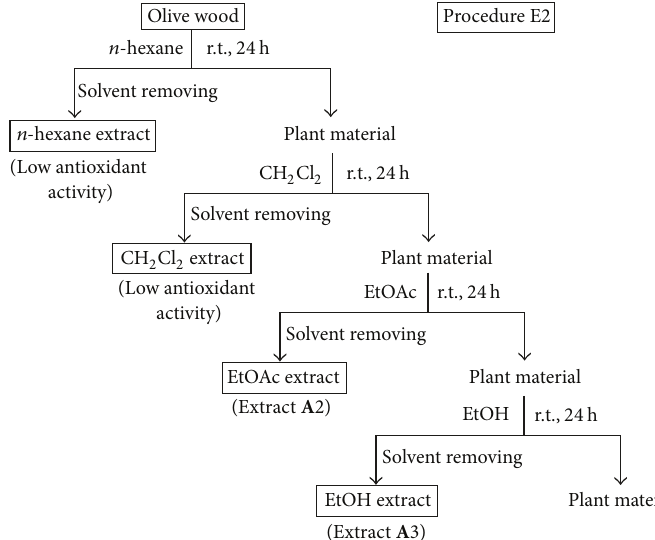
Figure 2: Solvent extractions of olive wood sample A following procedure E2.